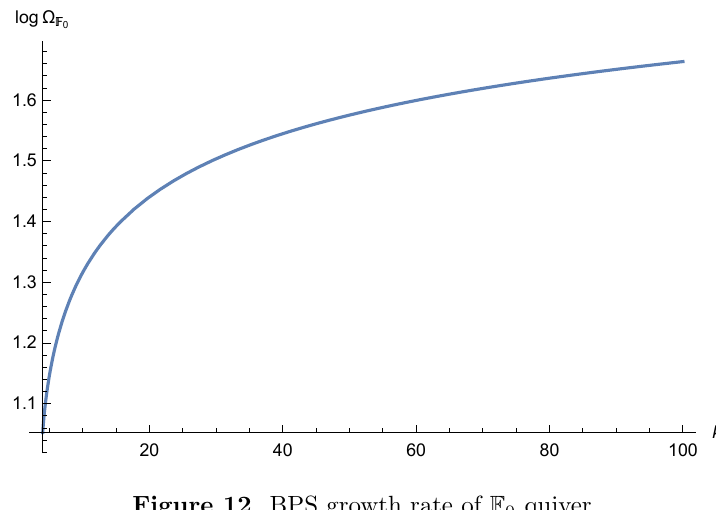
Figure 12 . BPS growth rate of F 0